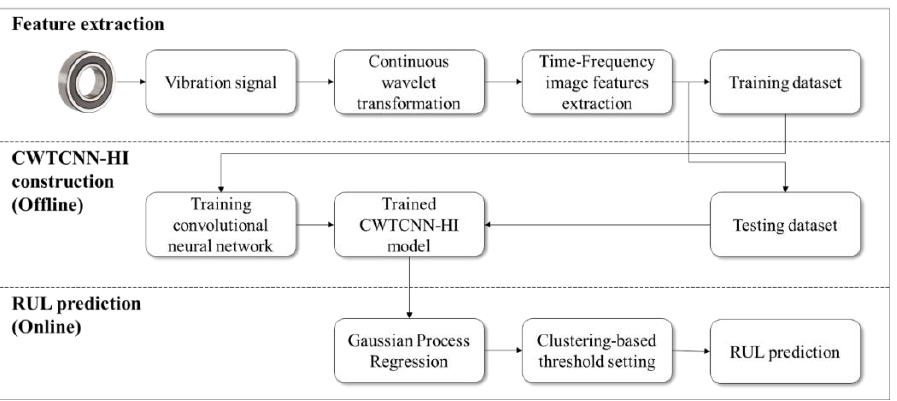
Figure 1. Framework of the Continuous Wavelet Transform and Convolutional Neural Network-based Health Indicator (CWTCNN-HI)-based prognostics method.